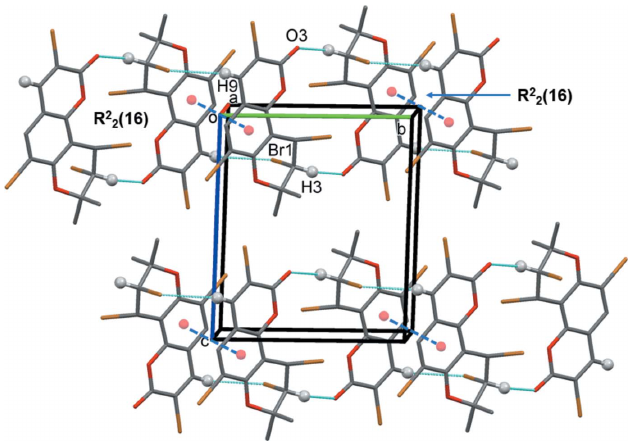
Figure 3 A view along the a axis of the crystal packing of the title compound, showing the hydrogen bonds (dashed cyan lines; see Table 1), the offset (cid:2) – (cid:2) interactions (blue dashed lines), and indicating the R 2 in the hydrogen-bonded chain. Only H atoms H3 and H9 have been included.